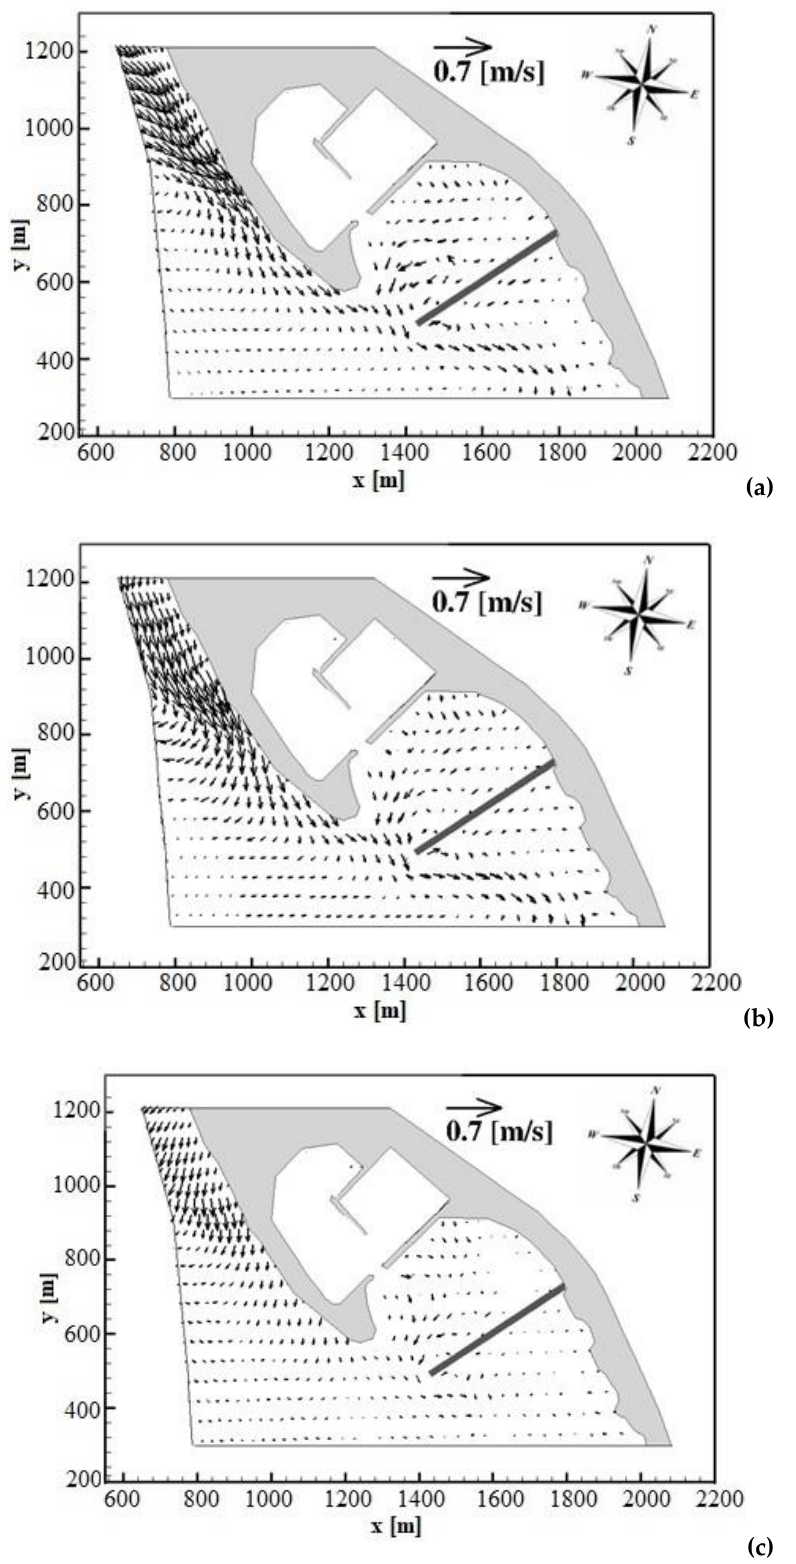
Figure 11. Time-averaged velocity field: ( a ) near the free surface, ( b ) at intermediate water depth, ( c ) near the bottom, obtained by the numerical simulation of the significant wave event in the project configuration of the Cetraro harbour.